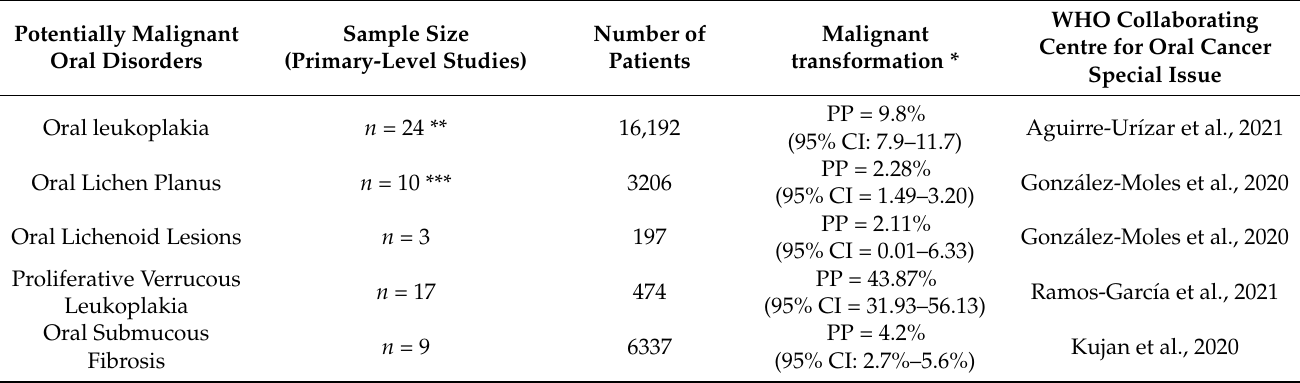
Table 3. Malignant transformation of potentially malignant oral disorders reported in the systematic reviews and meta-analyses published in the special issue organized by the World Health Organization Collaborating Centre for Oral